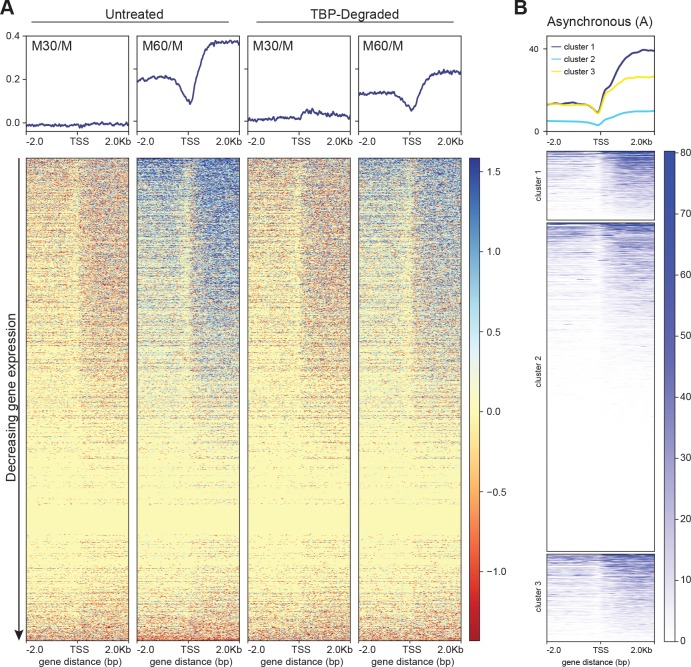
TBP degradation affects global reactivation following mitosis.(A) The log2 ratio of M30 and M60 reads relative to M reads were calculated for untreated and TBP-degraded samples (M30/M and M60/M, respectively). Global average of the log2 ratios were obtained and plotted for all genes centered at the TSS (top), and the corresponding heatmap for all genes are shown (bottom). (B) The normalized reads for the untreated asynchronous (A) sample was clustered using the same grouping as in Figure 6F.